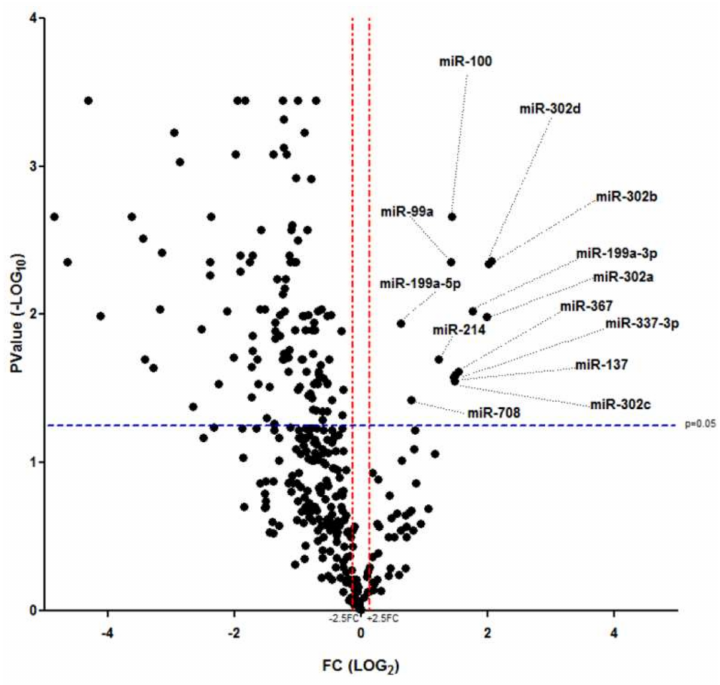
Figure 1. MicroRNA profiling of dedifferentiated human islet cells. Volcano plot analysis showing differentially expressed microRNAs in in vitro dedifferentiated human pancreatic islet cells vs. human native pancreatic islets. Black dots represent detected microRNAs based on the relative mean fold change (-Log FC) and p -values. Fold change cutoff (red lines) was set at 2.5-fold while p -values cutoff (blue line) was set at 0.05 based on FDR corrected Student’s t -test on normally distributed dCt values. The position and the identification name of upregulated microRNAs on the volcano plot is indicated by black dotted